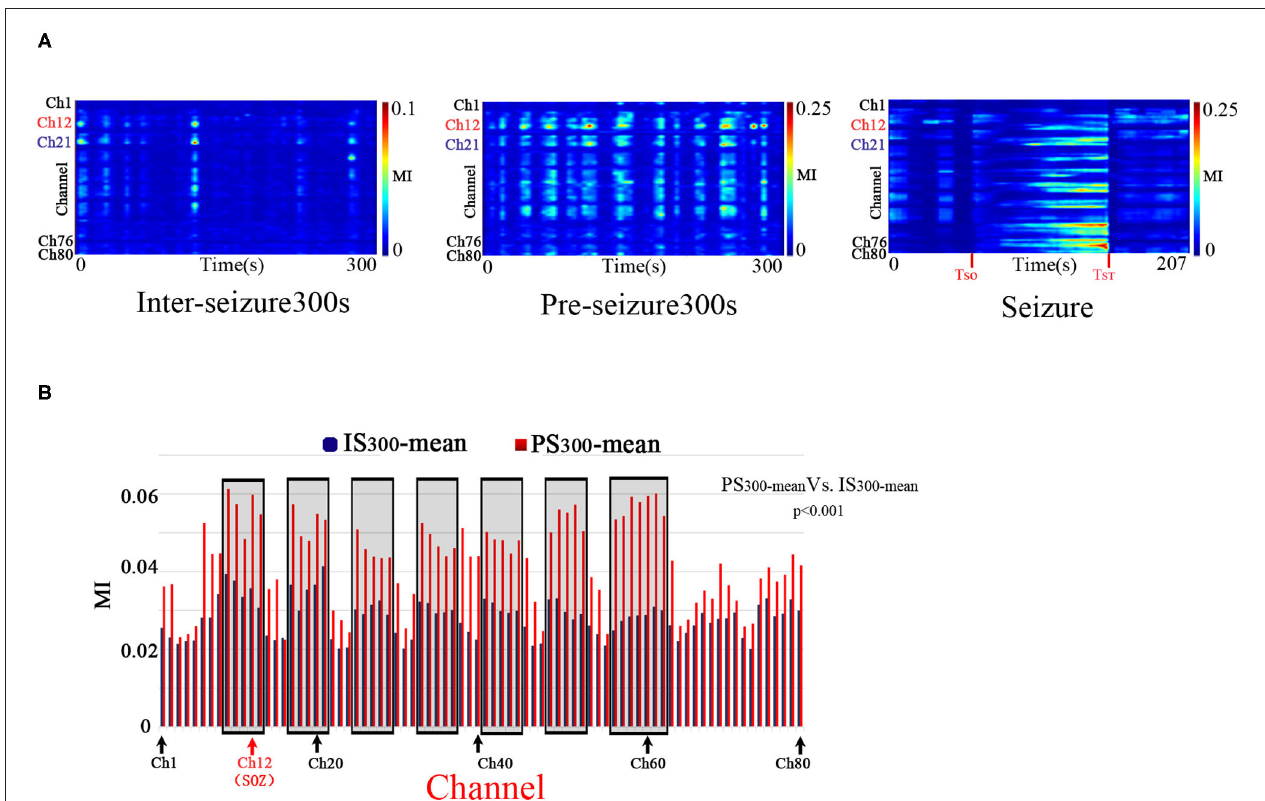
FIGURE 1 | Temporalspecificity of PAC. A: The characteristics of the PAC at different stages. Modulation was computed in 10-s windows shifted by 10s for all 80 electrode channels of Patient A across the IS 300 , PS 300 , and seizure recordings. The PAC rhythmically bursted in the IS 300 and PS 300 and continuously evolved during the seizure period. The PAC of IS 300 was rare, weak, and brief, while the PAC of PS 300 was rich, strong, and durable. The channel 12 (Ch12) was located in the SOZ (marked red); Ch21 was inside the resection margin but not in SOZ (marked blue); Ch1,76,80 was not in the resection margin and SOZ (marked black). B: Comparison of MI-mean values of each channel between the IS 300 and PS 300 period. The blue and red columns represent the MI mean-value of each channel during the IS 300 and PS 300 period, respectively. The black rectangles represent the resected